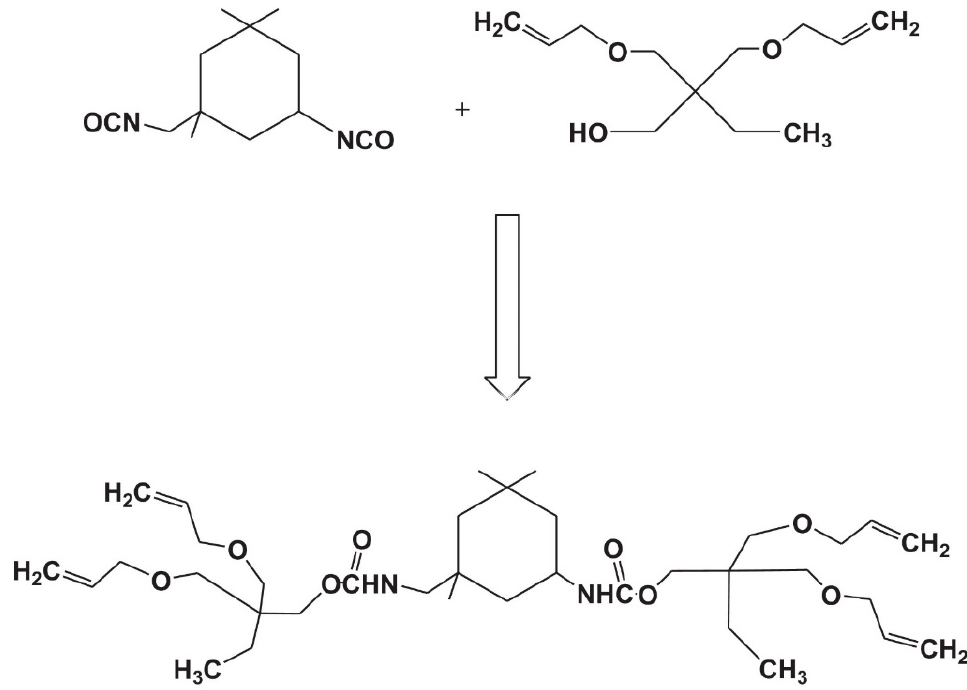
Figure 26. The reaction of isophorone diisocyanate (IPDI) and trimethylolpropane diallyl ether (DAE) for the synthesis of urethane tetra allyl ether monomer (UTAE), as reported by Beigi et al. Reprinted with permission from [63]; published by Elsevier, 2013.